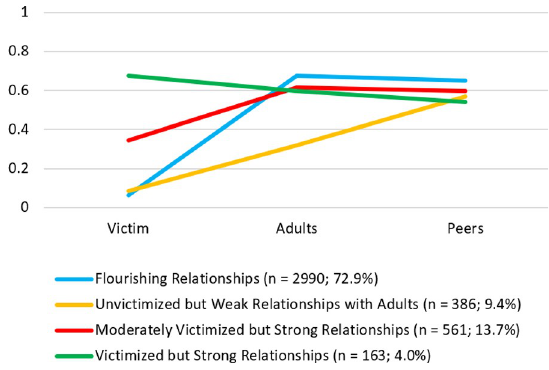
Fig 3. Selected 4-class latent profile analysis solution and class proportions among 4 th graders ( N = 4,100). Victim = victimization; Adults = connectedness with adults at home; Peers = peer belonging. Given their different response scales, scores on each variable were linearly transformed onto the same 0–1 scale using the proportion of maximum scoring transformation.